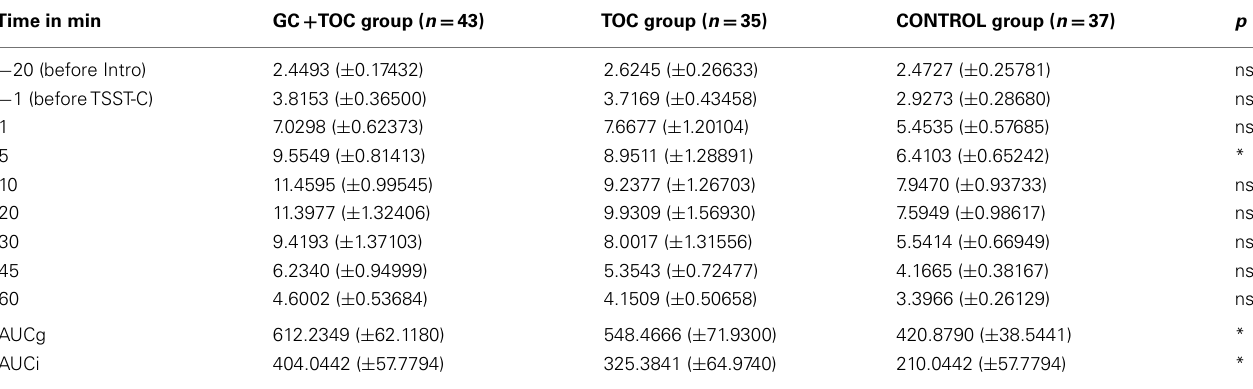
Table 3 | Measurement points (time in minutes) of the nine saliva samples and the assessed levels of cortisol in children with glucocorticoid (GC) and tocolytic (TOC) administration ( n = 43), children of theTOC group ( n = 35), and children of the CONTROL group ( n = 37; means ± SEM).